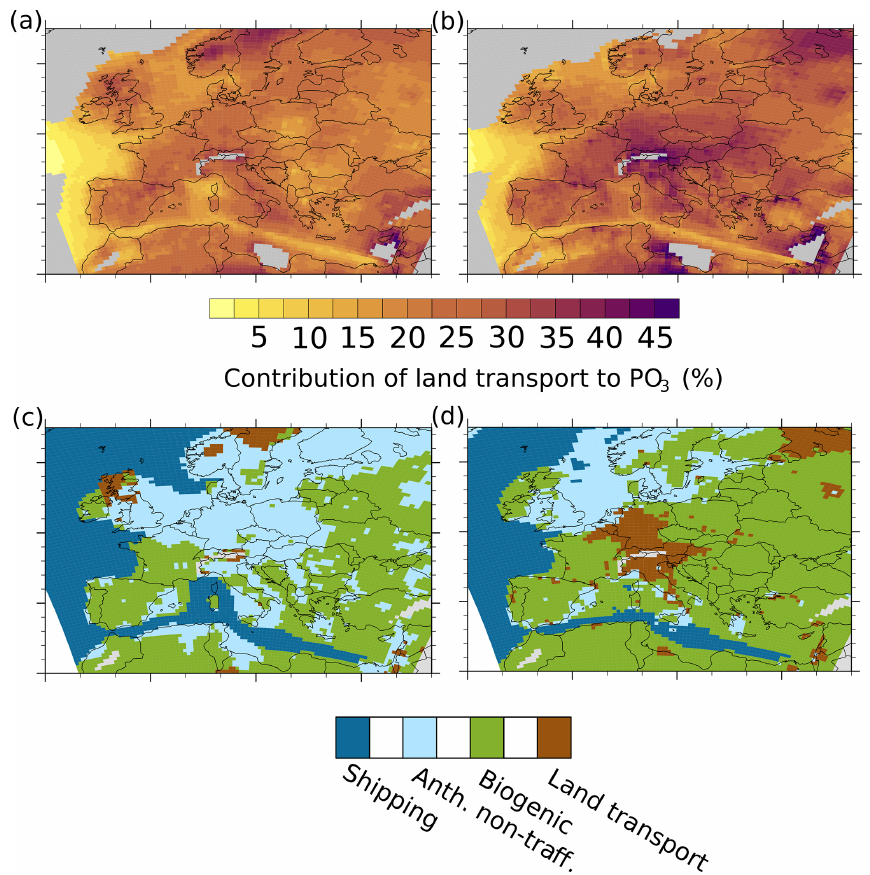
Figure 13. Contribution analysis for P O integrated from the surface up to 850hPa. Panels (a) and (b) show the relative contribution of land 3 transport emissions to P O (in percent) for the REF and the EVEU simulations, respectively. Panels (c) and (d) indicate the emission sectors 3 which contribute most to P O up to 850hPa for the REF and EVEU simulations, respectively. Averaged data for the period May–September 3 2008 to 2010 as simulated by CM50 are analysed. Grey areas in (a) and (b) indicate regions where P O In these regions no relative contributions are calculated for numerical